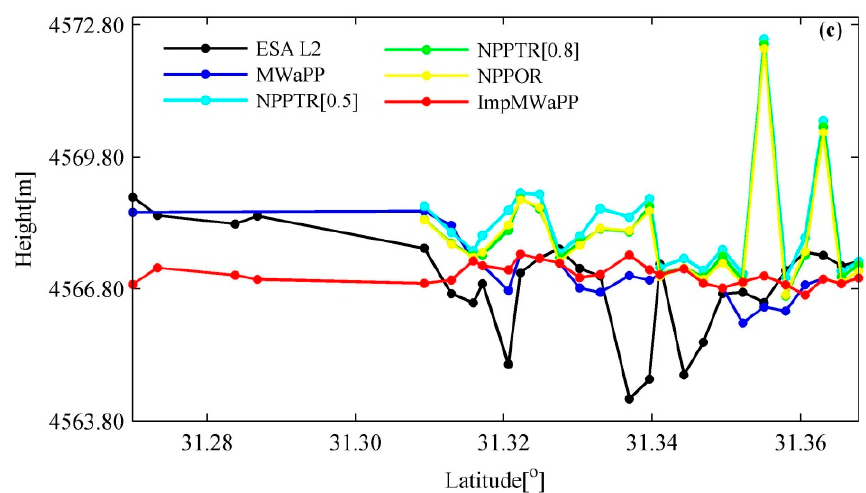
Figure 8. ( a ) Track over Bamco on 4 May 2014 (black and red solid points mark the nadir and corresponding Level-2 positions, respectively), ( b ) corresponding waveforms, and ( c ) retracked water levels.